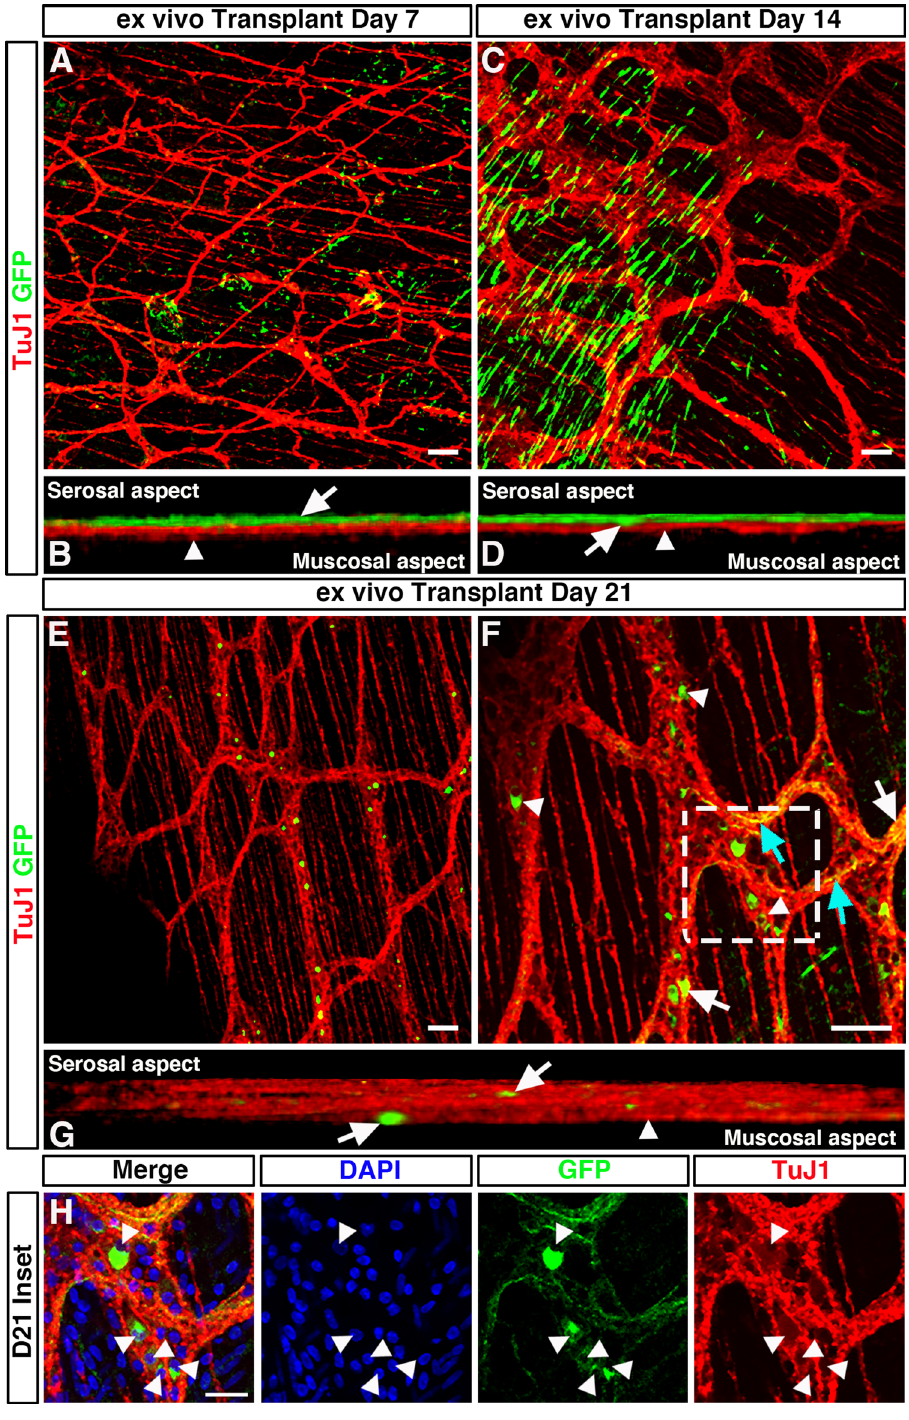
Figure 4. Temporal integration of transplanted ENSC within ex vivo organotypically cultured C57BL/6J colon. ( A ) Representative confocal z-stack image of GFP + ( green ) ENSC-derived cells and the endogenous TuJ1 + ( red ) ENS 7-days after ex vivo transplantation. ( B ) Orthogonal view of 3D rendered confocal stack showing donor GFP + cells at the serosal aspect ( arrow) and TuJ1 + myenteric plexus (arrowhead) 7-days after ex vivo transplantation. ( C ) Representative confocal z-stack image of donor GFP + ( green ) cells and the endogenous TuJ1 + ( red ) ENS 7-days after ex vivo transplantation. ( D ) Orthogonal view of 3D rendered confocal stack, 14-days after ex vivo transplantation, showing donor GFP + cell penetration ( arrow ) from the serosal aspect towards the myenteric plexus (arrowhead). ( E , F ) Representative low- ( E ), and high-power ( F ) confocal z-stacked images of GFP + ( green ) donor cells within the recipient TuJ1 + ( red ) myenteric plexus, 21-days after ex vivo transplantation. Donor cells were observed as both individual cells, and donor cell clusters, within ganglia like structures (arrowheads). Donor derived GFP + TuJ1 + neurons (arrows) appeared to extend GFP + TuJ1 + neuronal fibres which traced the endogenous neural network (cyan arrows). ( G ) Orthogonal view of 3D rendered confocal stack showing donor GFP + cells ( arrows) within the endogenous TuJ1 + myenteric plexus (arrowhead) 21-days after ex vivo transplantation. ( H ) Zoomed image of inset shown in ( F ) showing high magnification of donor cell bodies (arrowheads) incorporated within ganglia as indicated by DAPI ( blue ), GFP ( green ) and TuJ1 ( red ). Scale bars represent 50 μm ( A – G ), 25 μm ( H